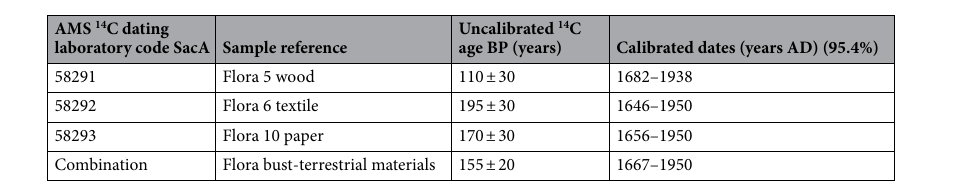
Table 2. Uncalibrated and calibrated 14 C dates of the wood, textile and paper samples of the Flora bust.